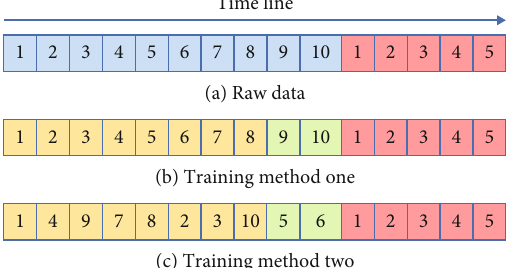
Figure 3: Sensor locations. (a) Beidou GPS sensor locations. (b) Bottom soil pressure of foot blades sensor locations. Table 1: Sample sinking amount data.